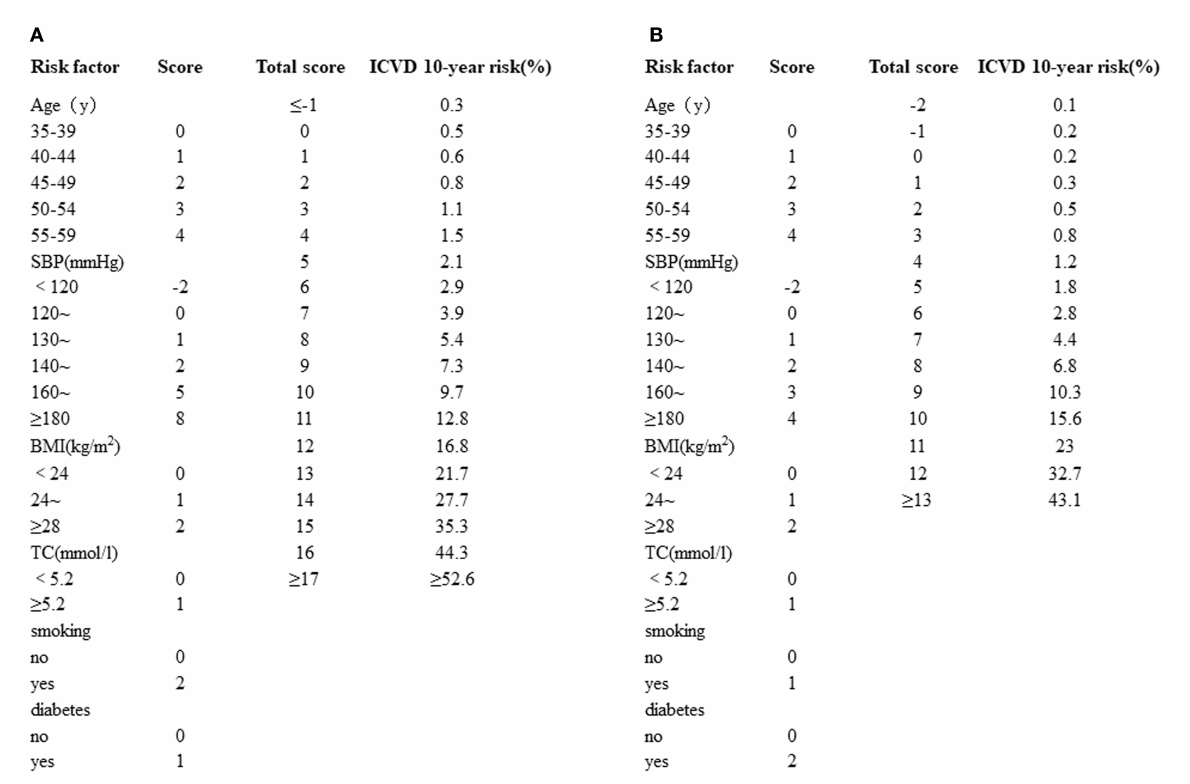
not significantly different from those in the female subgroup (Tables